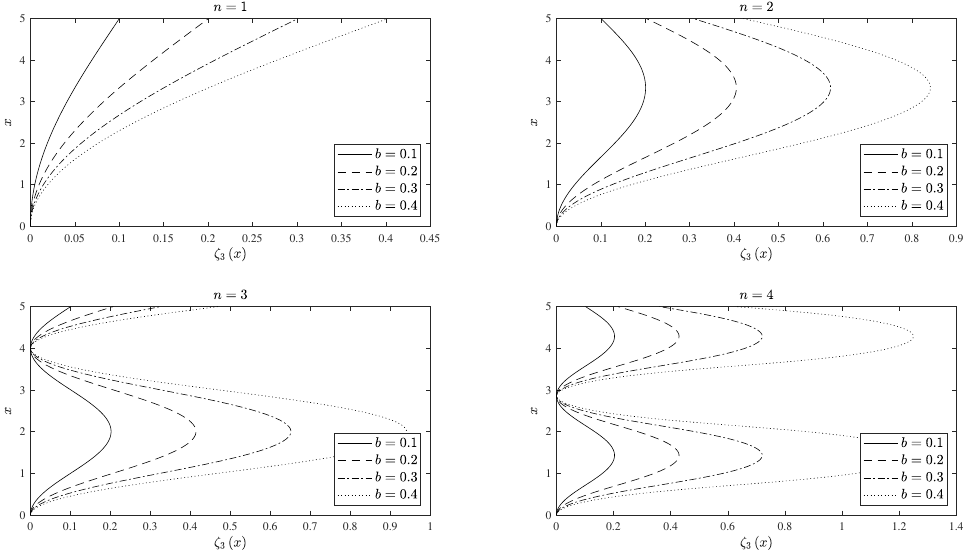
Figure 8. Different mode shapes of the buckled elastic cantilever beam for the four lowest buckling forces, n = 1, . . . ,4, as functions of the indeterminate constant b . The length of the beam is L = 5.